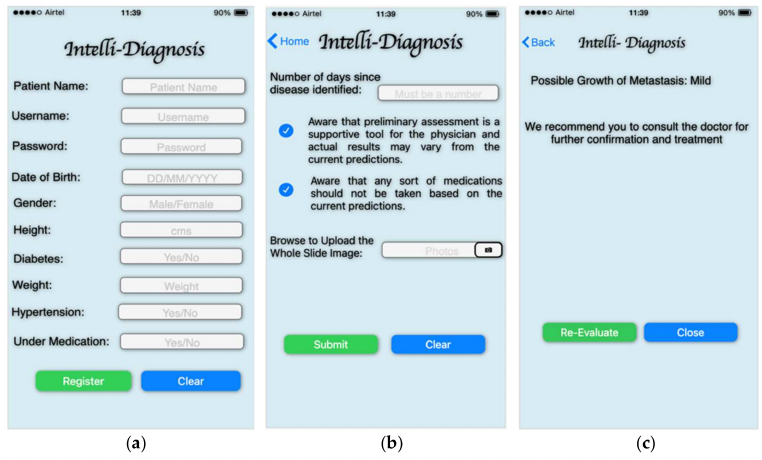
Figure 18. Image of user-interface of the future perspective